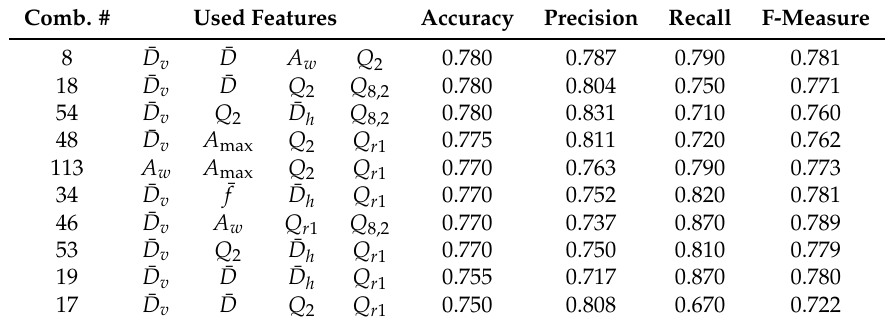
Table 2. Accuracy, precision, recall, and F-measure for each feature combination in the two-class problem. The list is sorted in descending order of accuracy.